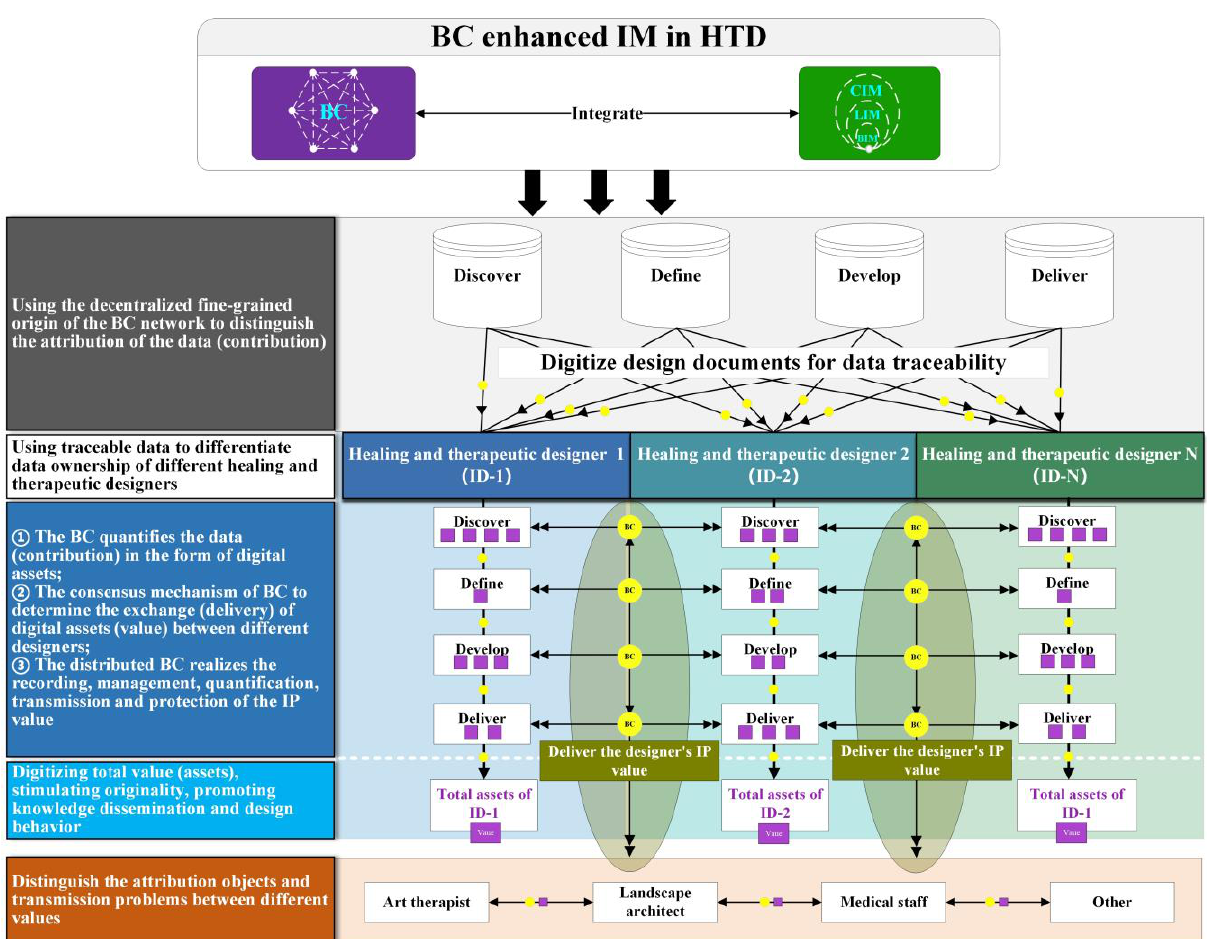
Figure 12. Quantifying the value of design with BC enhanced IM in HTD (generated by authors).